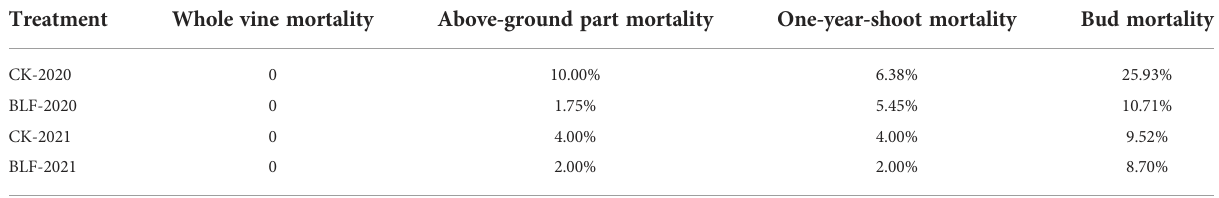
TABLE 2 The effect of spraying BLF on vine, one-year-shoot, and bud mortality. Treatment